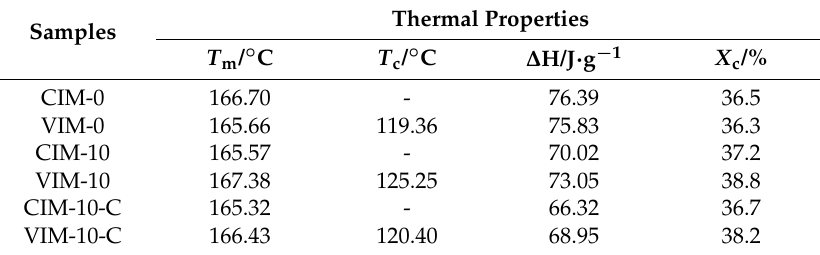
Figure 4. DSC curves: ( a ) heating process and ( b ) cooling process. Table 3. Thermal properties during heating and cooling.